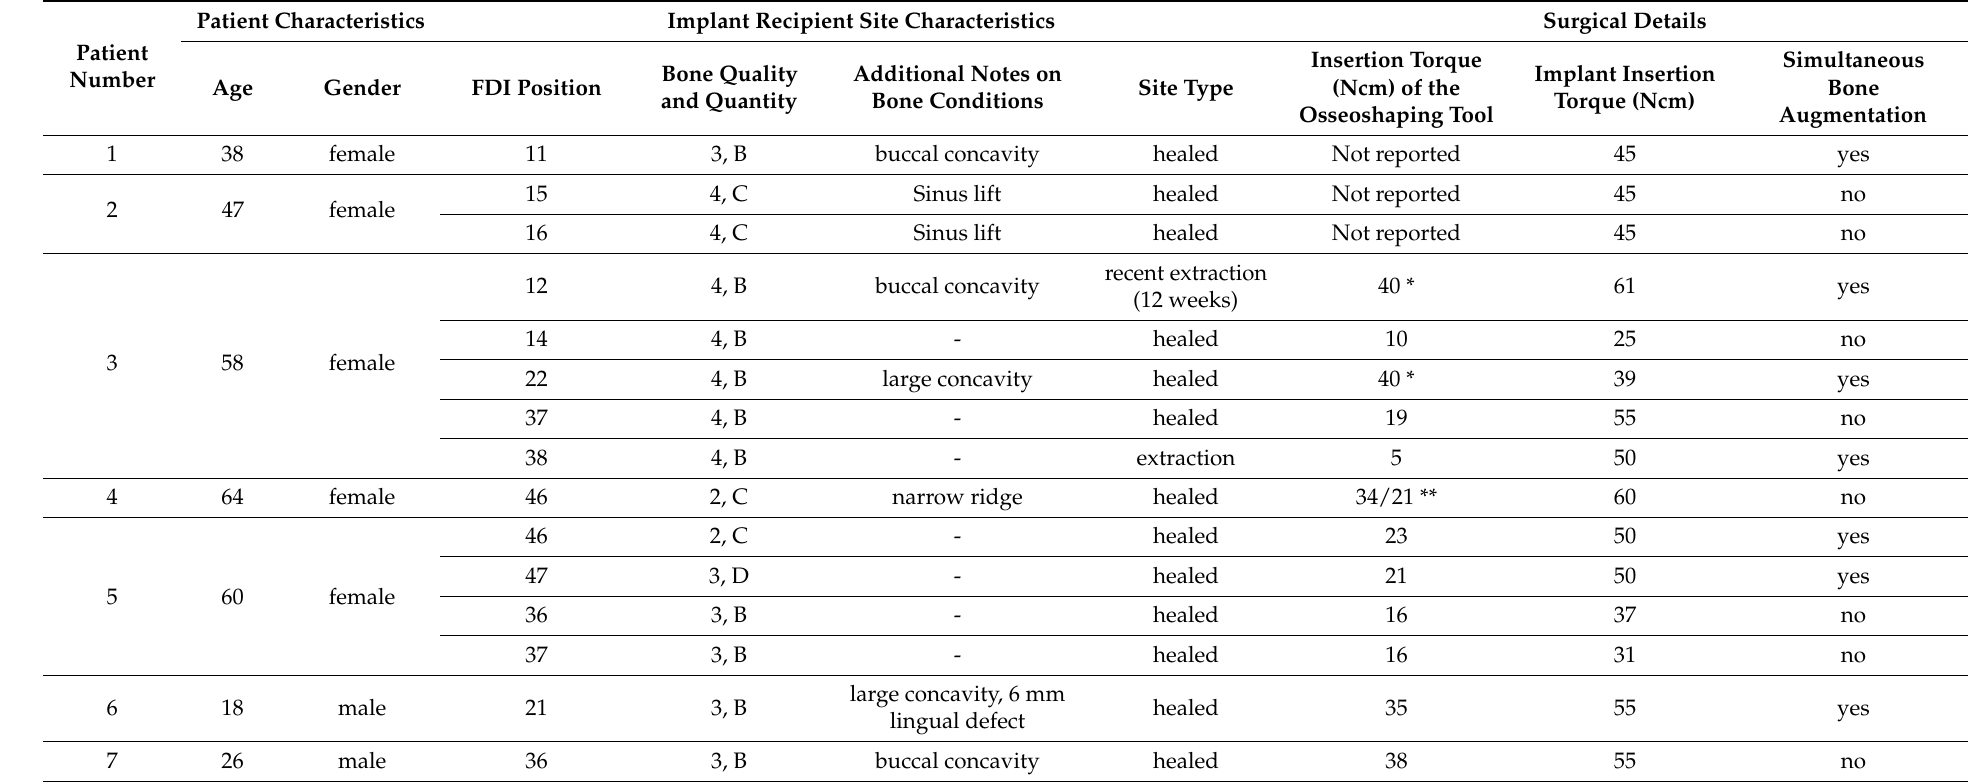
Table 3. Summary of patient and surgical characteristics included in the clinical case